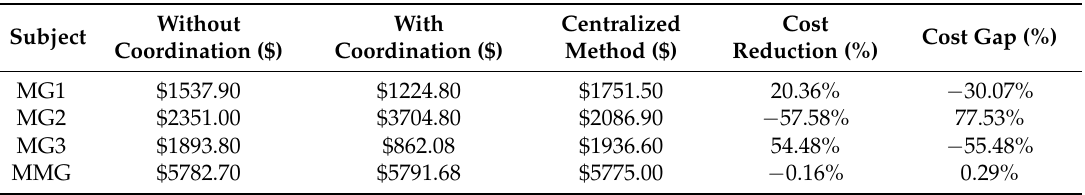
Table 7. A summary of the results comparison without penalty